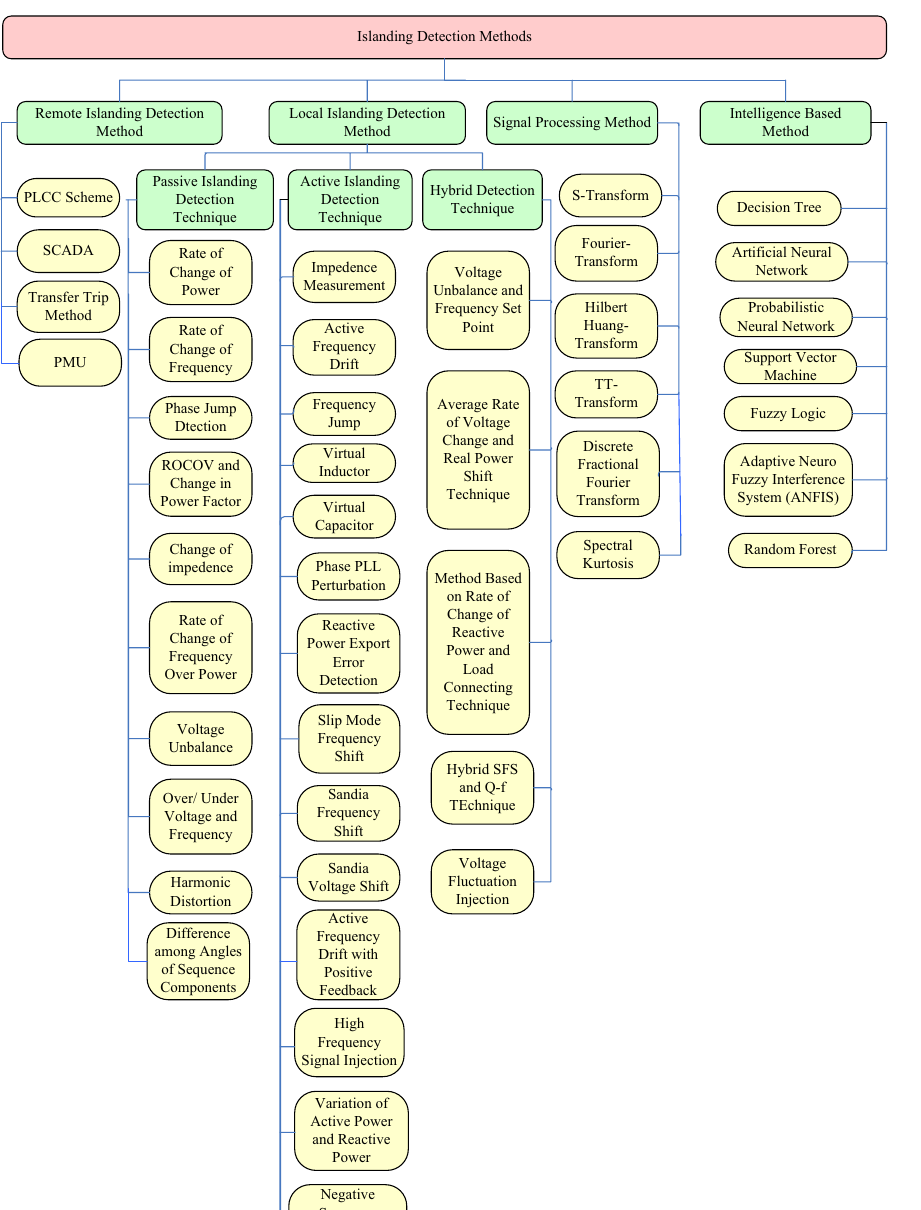
Fig. 2 Classification of various islanding detection methods [4, 36, 37]